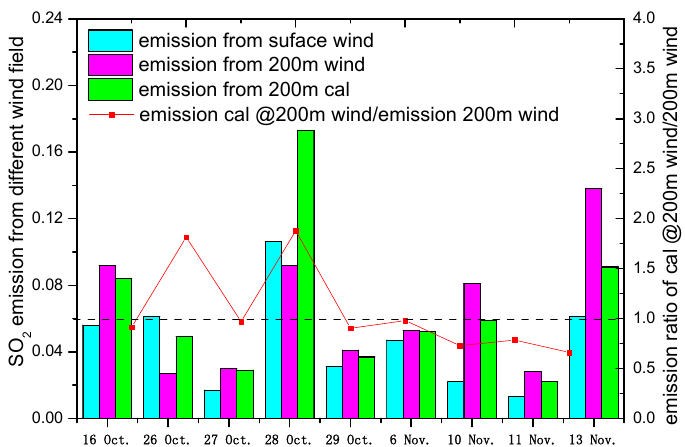
Figure 7. Three types of wind speed. Blue indicates the wind speed source from ground-based wind; pink indicates the wind speed source from 200 m height (LIDAR or model); and green indicates the wind speed source from 200 m height with calculation from ground-based wind.